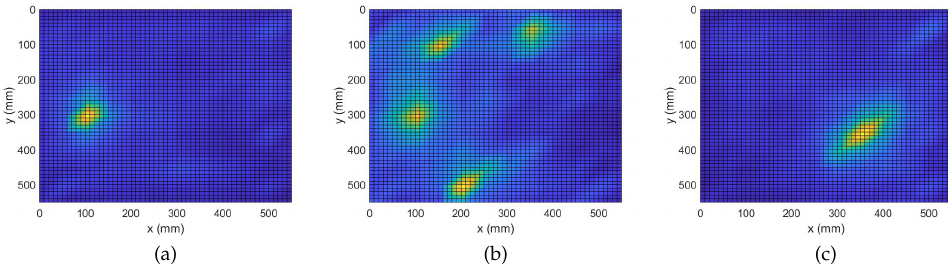
Figure 7. Damage Detection with Full Array MUSIC. ( a ) M 1 : 1 point-like mass. ( b ) M 4 : 4 point-like masses. ( c ) M E : 1 extended